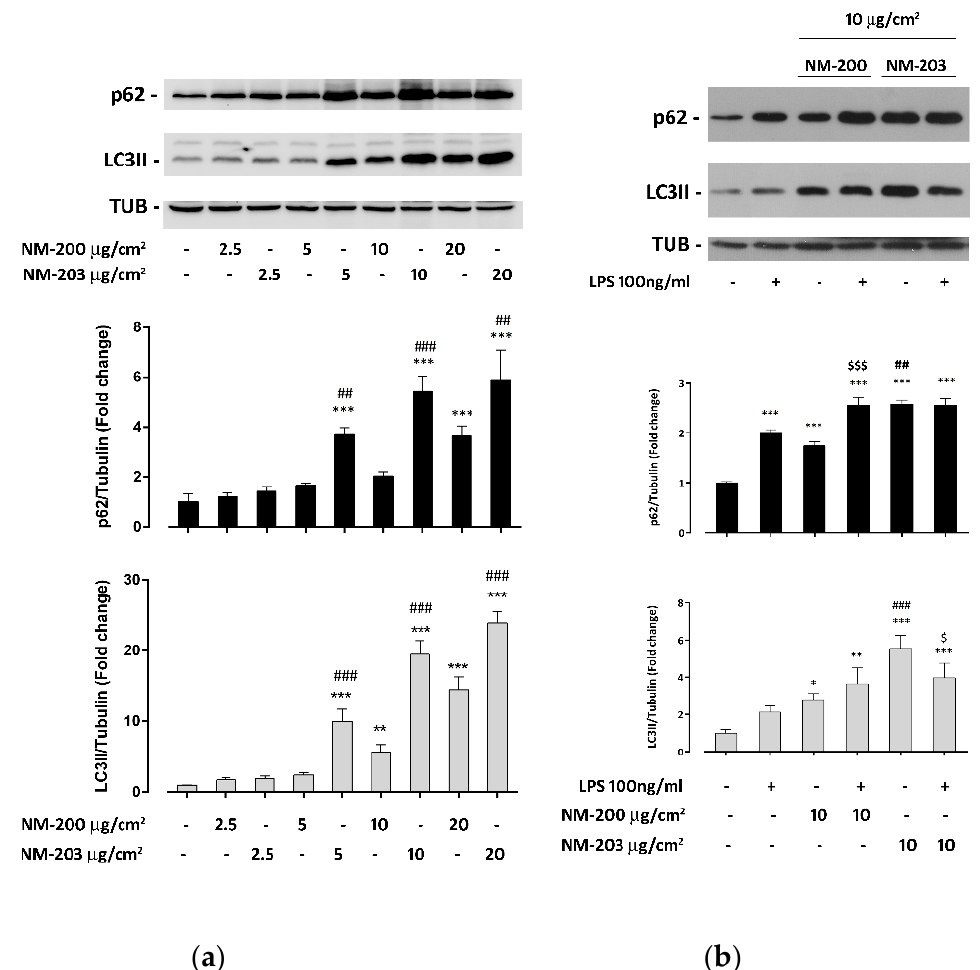
Figure 2. Impact of NM-200 and NM-203 on the autophagic flux. THP-1 cells were exposed for 48 h to ( a ) increasing doses of NM-200 or NM-203 or ( b ) to 10 µ g / cm 2 of NM-200 or NM-203 in the absence or in the presence of LPS (100 ng / mL) for the last 24 h. At the end of the experimental treatments, the cells were processed, and the protein expression of p62, LC3II and tubulin was determined. Bars report means of the relative abundance of LC3II (grey bars) or p62 (black bars) ± SD (n = 3). * p < 0.05; ** p < 0.01; *** p < 0.001 vs. untreated cells; $ p < 0.05; $$$ p < 0.001 vs. the same dose of NM-203 without LPS; ## p < 0.01; ### p < 0.001 vs. the corresponding dose of NM-200, one-way ANOVA.